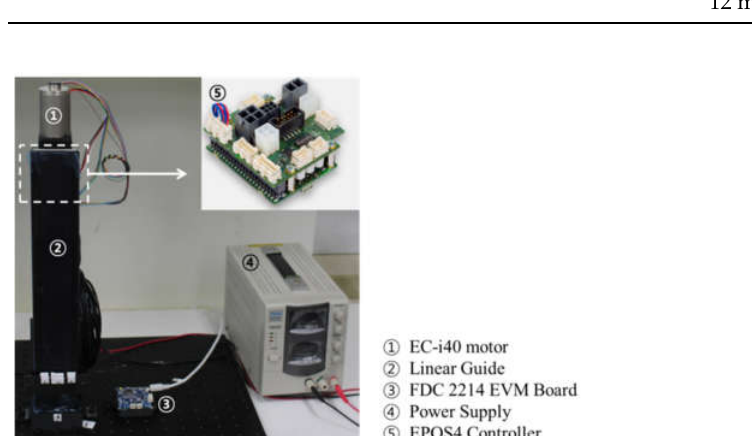
Figure 6. Subject walking on the treadmill with a marked brace. 3. Experiments 3.1. Sensor Characterizations Repeatability tests were performed to characterize the sensor. In [15,16], the authors characterized their sensor at a speed of 25 mm/s, which is the maximum tension speed of a conventional tension test machine. We decided to use a linear actuation system with the same tension speed as mentioned above for the sensor characterization experiments. During 100 cycles of oscillation, the amplitude of the sensing value was recorded using a capacitance evaluation chip FDC 2214 EVM (Texas Instruments, Texas, USA). As a subject moved their ankle with a brace and sensor, it was difficult for the sen- sors to extend to over 150% of their own length; they could be extended to 180% of their own length at a maximum of 30% pre-tension. We decided on a maximum tension range for all the sensors of 150% of their own length in the characterization experiment. A customized linear actuator was used in the experiment. A linear guide (SKR3306C, Samik THK, Suwon, Korea), an EC motor (667306 EC-i40, Maxon Motor, Sachseln, Swit- zerland) and a motor controller (EPOS4, Maxon Motor, Sachseln, Switzerland) were used for the linear actuator. The linear actuator moved 6 mm in one revolution of the EC motor. Using this ratio, the oscillation range was converted into an incremental encoder unit of the EC motor. The EC motor was actuated with a sinusoidal profile at a speed of 250 rpm (25 mm/s) with respect to the sensors. The mount for fixing the sensor was printed using a 3D printer (M200, Zortax, Seongnam, Korea). A metal hook was sewed to the mount. Figure 7a shows the linear actuator system. During oscillation, the sensor value was rec-